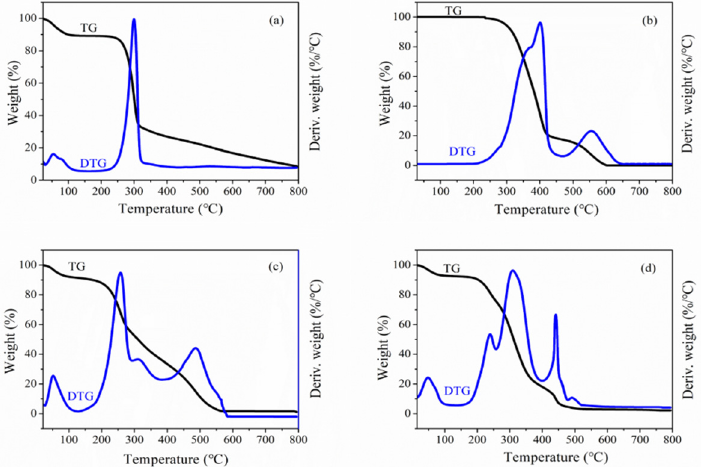
Figure 4. ( a ) TG and DTG curves of BX. ( b ) TG and DTG curves of AD. ( c ) TG and DTG curves of FA-BX/AD. ( d ) TG and DTG curves of BA F G 2 (where the TG curve is marked in black and the DTG curve is marked in blue).